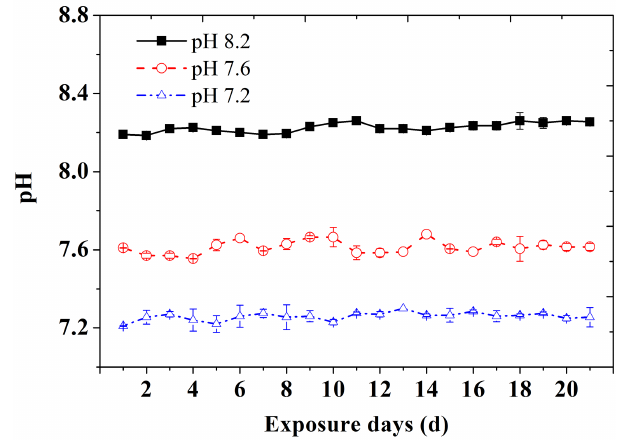
Figure 2. Measured mean pH NBS of seawater in three pH treat- ments during 21d of exposure ( n =